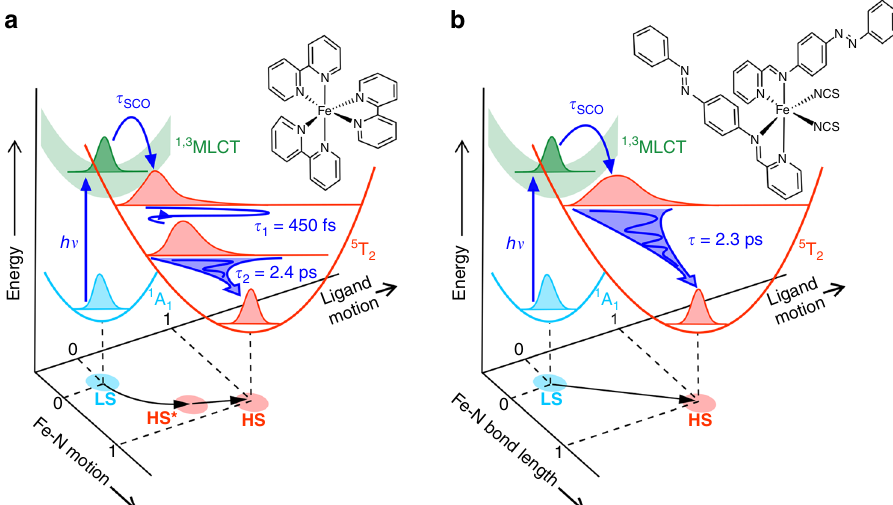
Fig. 5 Schematic representation of the proposed reaction pathway. a For BPY, photoexcitation is followed by radiationless spin transitions. The vibrationally hot high spin state has a narrow Fe – N bond distribution, which is impulsively displaced within 450 fs. It vibrationally cools inside the high spin state within 2.4 ps. b For AZA, the ligand structural rearrangement is statistically distributed during IVR, resulting in a broader distribution of structures, which narrows over 2.3 ps as IVR activates ligand motions and further molecular Fig. 5a). Given that the ligands in BPY (2-2 ’ -bipyridine) are much